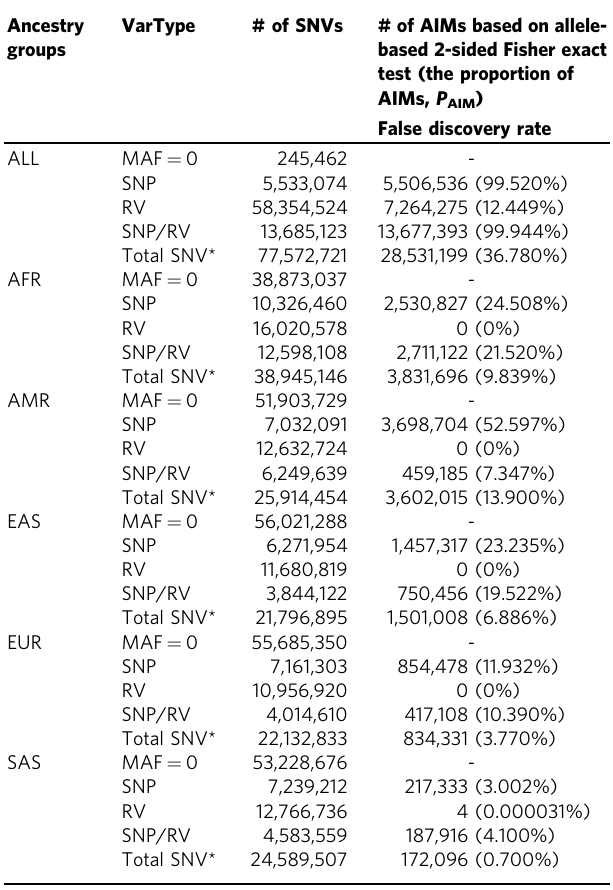
Table 1 Global distributions of AIMs.